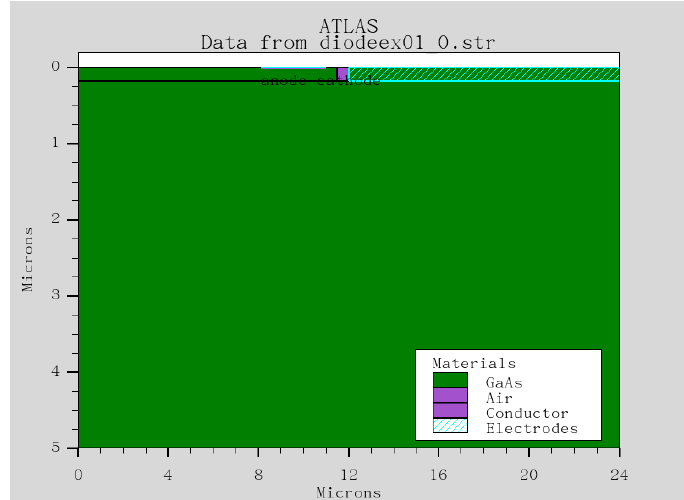
Figure 8. Physics-based Schottky junction model in Atlas.